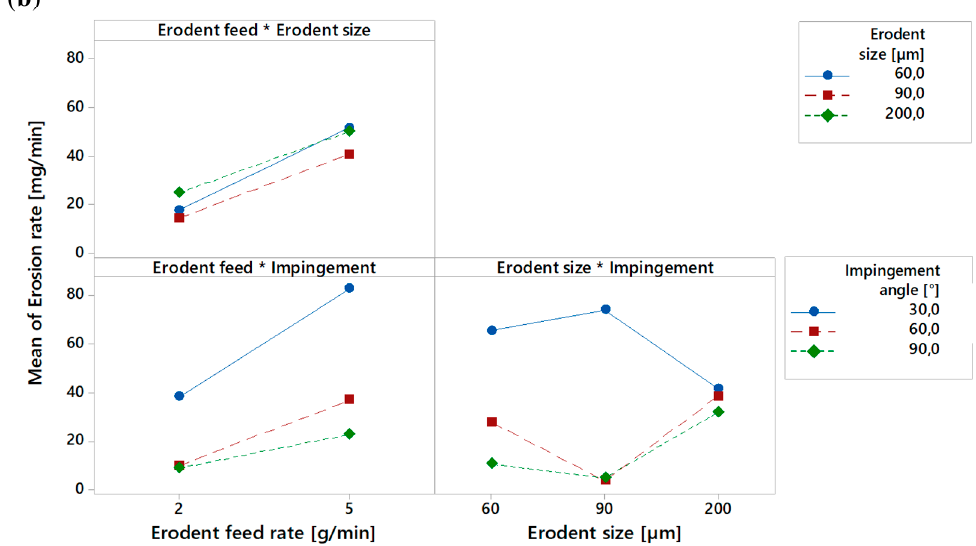
Figure 5. Main e ff ect plot ( a ) and interaction plot ( b ) for Erosion rate [mg / Figure 5. Main effect plot ( a ) and interaction plot ( b ) for Erosion rate [mg/min].